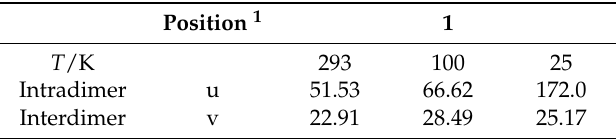
Table 6. Transfer integrals (m · eV) between the [Ni(mnt) 2 ] molecules in